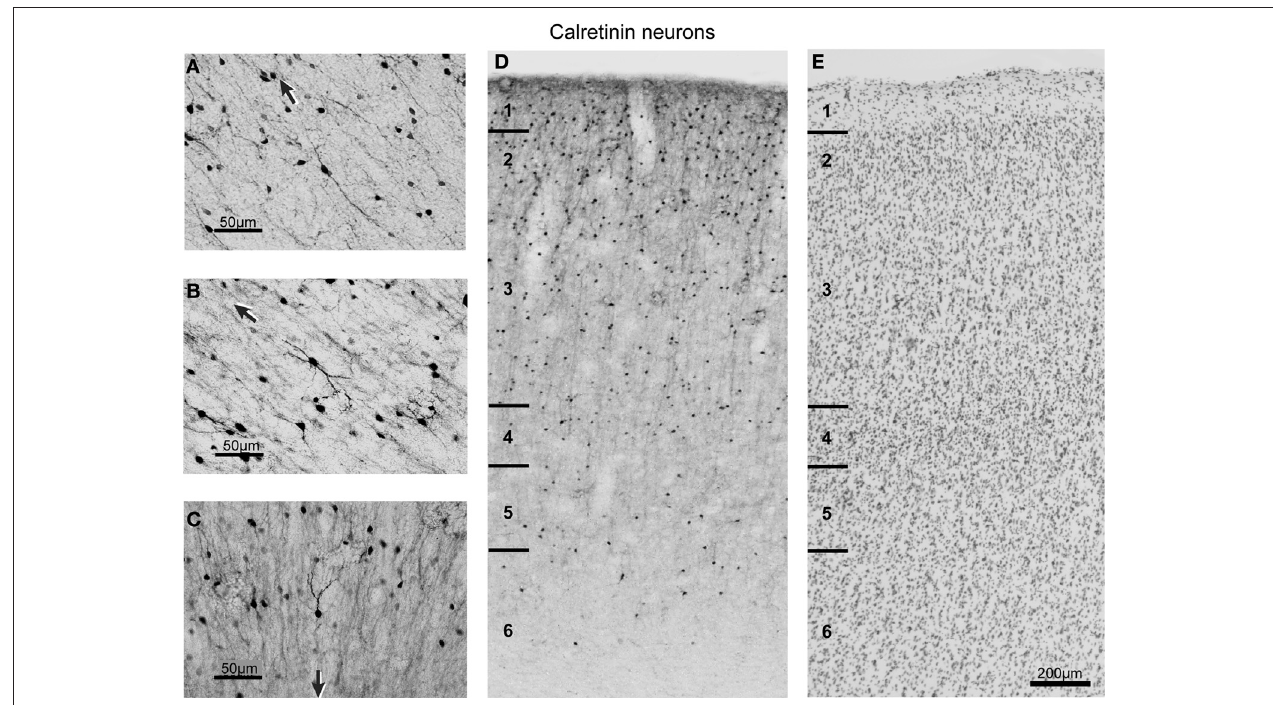
FIGURE 4 | Brightfi eld photomicrographs of CR-labeled neurons in FEF. (A–C) High magnifi cation of different morphological classes of CR- labeled neurons found in FEF. The black arrow in each panel points toward the pial surface. (D) Distribution of the CR-labeled neurons across the